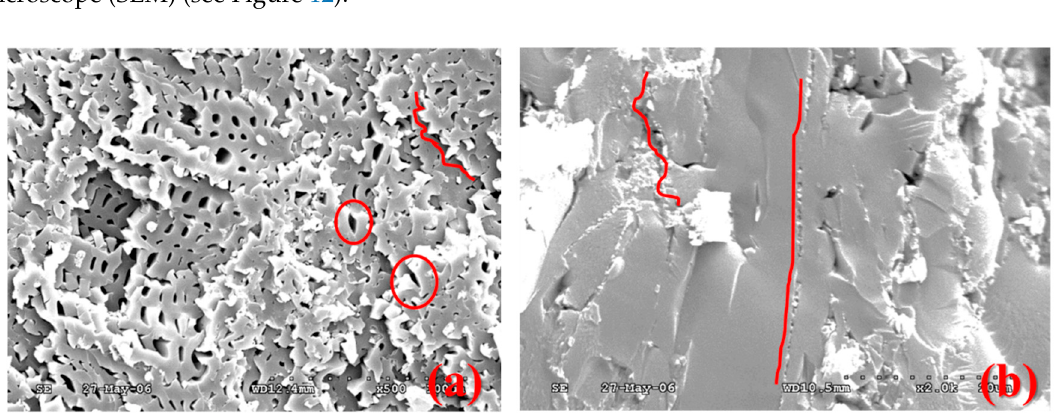
Figure 12. SEM images of microstructures of coal mass before loading. ( a ) Primary pores are abundant and crack was even, mostly appeared as spongy shape under magnification of 500 times; ( b ) Numerous cracks were found in pore clusters under magnification of 5000 times. Red curves refer to the tracks of cracks while red circles represent the location of cracks.